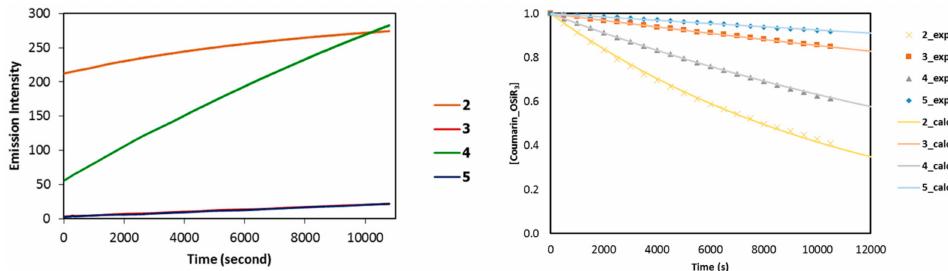
Figure 5. ( Left ) Fluorescence signal changes upon dissolving 2 , 3 , 4 , and 5 (2 µ M) in HEPES beffer solution pH 7.4 (contain 0.8% MeCN) for 3 h. ( Right ) Kinetic plots for the hydrolysis of 2 , 3 , 4 , and 5 (2 µ M) in HEPES buffer solution pH 7.4 (contain 0.8% MeCN).